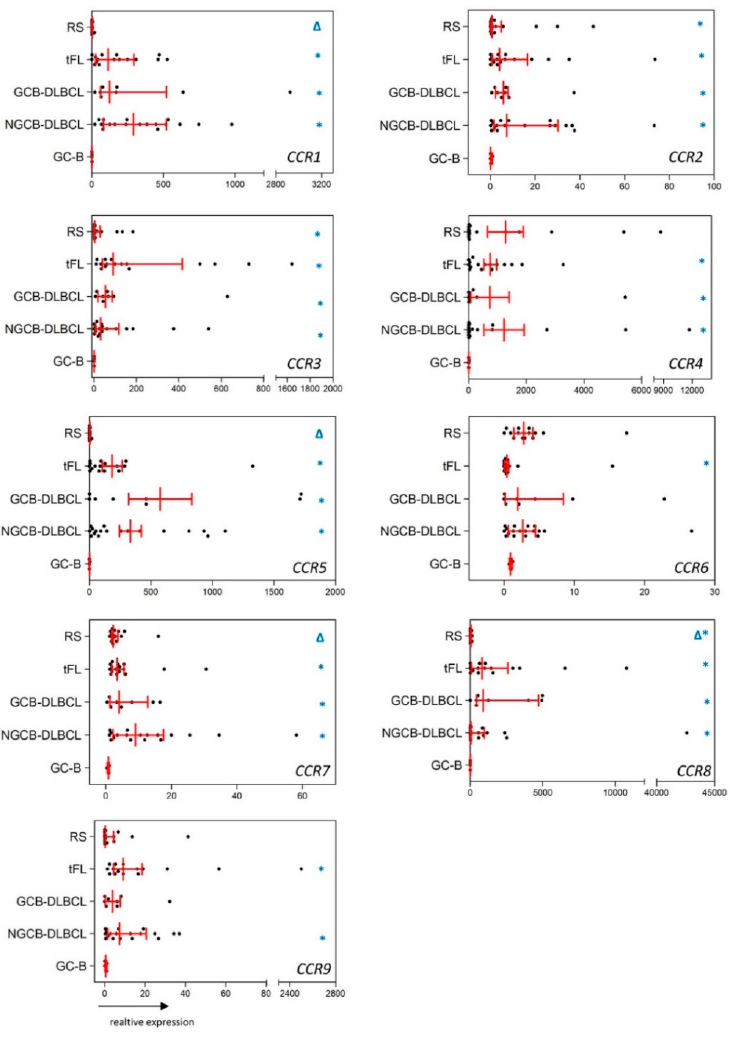
Figure 1. mRNA expression of CCR chemokine receptors in RS, tFL, GCB-DLBCL, NGCB-DLBCL, and GC-B as healthy controls. Scatter plots show the mRNA expression of CCR1 , CCR2 , CCR3 , CCR4 , CCR5 , CCR6 , CCR7 , CCR8 , and CCR9 in RS, tFL, GCB-DLBCL, NGCB-DLBCL, and GC-B. GC-B denotes germinal center B-cells, which were isolated from non-neoplastic tonsils. Values of gene expression are calculated as relative expression. Red lines indicate median and interquartile range. * depicted in blue indicates significantly dysregulated chemokine receptors of a given lym- phoma subgroup compared with GC-B ( p < 0.05). ∆ depicted in blue indicates significantly dysregulated chemokine receptors of RS compared with the tFl, GCB-, and NGCB-DLBCL ( p < 0.05). In the group of CXCR, CX3CR1, and XCR1 chemokine receptors, five activation-in- duced chemokine receptors [8], CXCR1 , CXCR2 , CXCR6 , CX3CR1 , and XCR1 were ex- pressed at least 27-fold more highly in GCB-DLBCL, NGCB-DLBCL, and tFL, compared with GC-B (Figure 2, p < 0.043). In RS, we detected an 18-fold higher expression of CXCR2 , CX3CR1 , and XCR1 compared with GC-B (Figure 2, p < 0.048). Interestingly, we did not ob- serve any substantial differences between GC-B and the lymphoma entities for the B-cell ho- meostatic chemokine receptors, CXCR3 , CXCR4 , and CXCR5 [11–13] (Figure S1, Supplemen- tary Materials) .